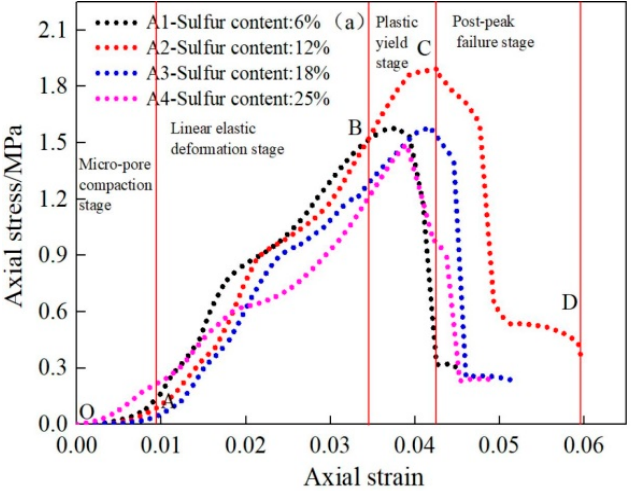
Figure 3. SEM images of tailing samples with different sulfide content [31].